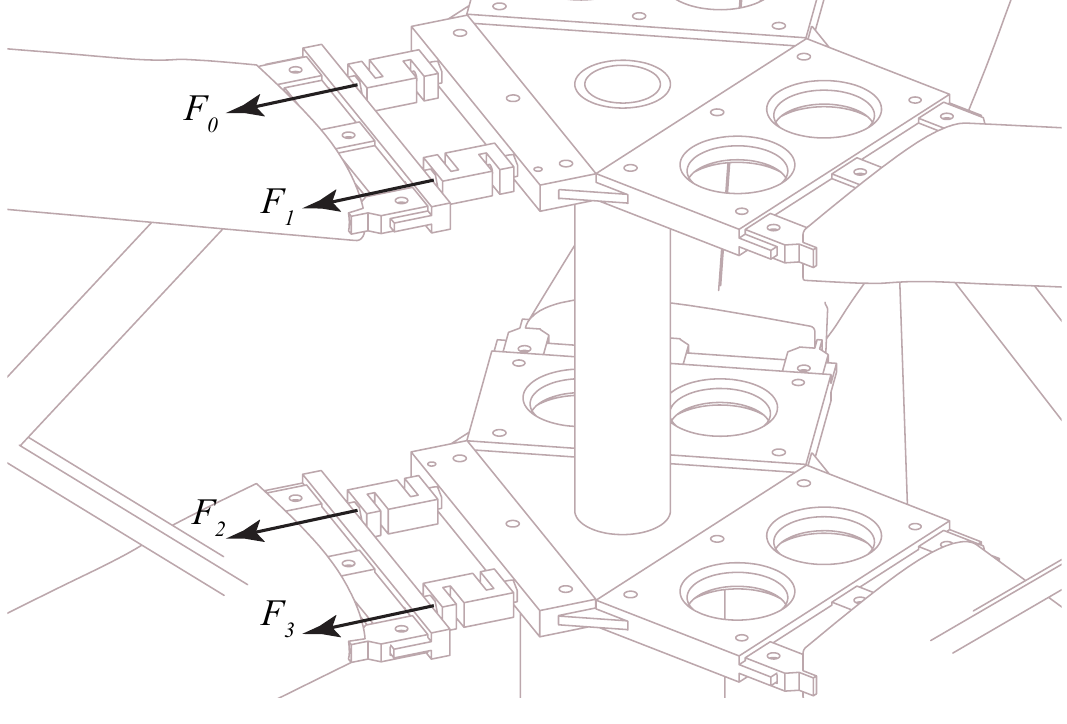
Figure 4. The notations of the measured